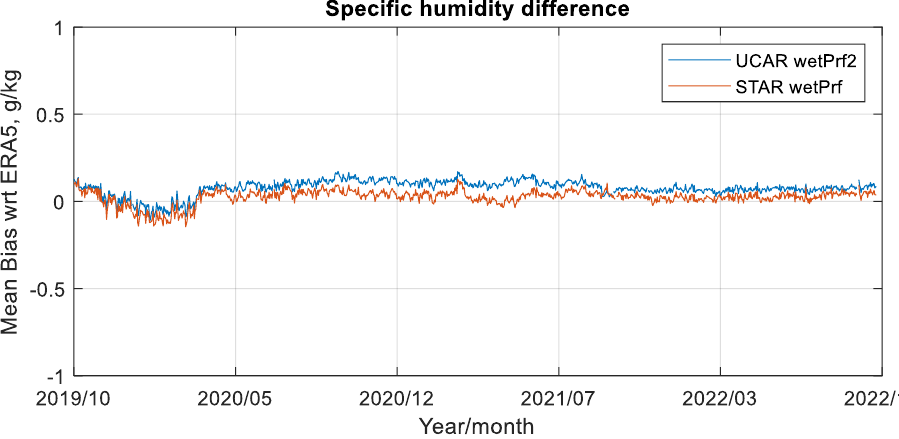
Figure 14. Similar to 13 but for COSMIC-2 and ERA-5 water vapor specific humidity mean difference time series at 700 mb for STAR WetPrf (in red) and UCAR WetPrf2 (in blue).